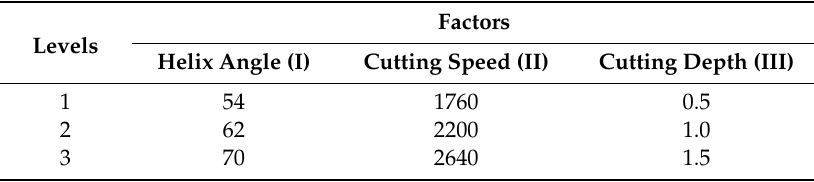
Table 3. Cutting parameter including helix angle (°), cutting speed (m/min) and depth (mm), and their levels.